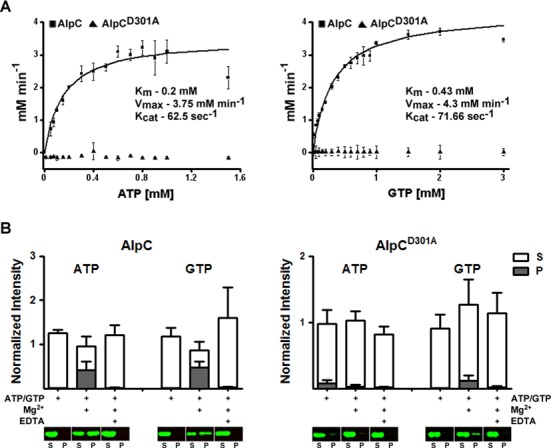
AlpC hydrolyses ATP and GTP, in vitro. (A) Nucleotide hydrolysis was assayed using a coupled assay in which ATP/GTP was continuously regenerated from ADP/GDP (see Materials and Methods). The nucleotide hydrolysis rate was assayed in the presence of 1 μM protein with increasing concentration of ATP/GTP. Plots are fitted for Michaelis–Menten kinetics. The hydrolysis kinetics of AlpC is similar for both ATP and GTP. Mutation of the conserved aspartic acid of the phosphate 2 motif of AlpC (AlpCD301A) abrogates nucleotide hydrolysis. Error bars indicate the standard error of three independent experiments. (B) AlpC assembles into higher-ordered protein complexes. Polymerization of 2 μM AlpC or AlpCD301A was assayed at 30°C in the presence of 2 mM nucleotide (ATP or GTP), 2 mM Mg2+ and/or 4 mM EDTA, as indicated, and detected by means of sedimentation assays and quantitative Western blot. All fluorescence intensities are normalized against AlpC or AplCD301A protein samples lacking nucleotide, Mg2+ or EDTA. Sedimentation of AlpC is dependent on the presence of nucleotide and Mg2+. In the presence of EDTA sedimentation of AlpC is abolished. Sedimentation of the hydrolytic inactive mutant (AlpCD301A) was observed (in the presence of ATP only or GTP and Mg2+), however, significantly reduced compared to the wild-type AlpC protein. In the presence of EDTA AlpCD301A did not sediment. A montage of the immunoblotted samples is shown in the lower part of the figure. S, supernatant; P, pellet. Error bars indicate the standard error of three independent experiments.